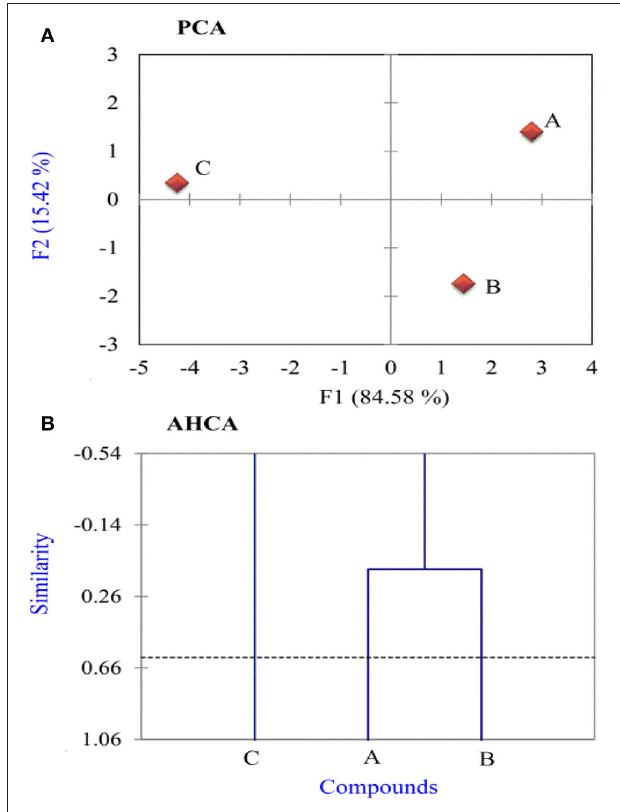
FIGURE 4 | (A) Score and (B) dendrogram plots obtained for three studied